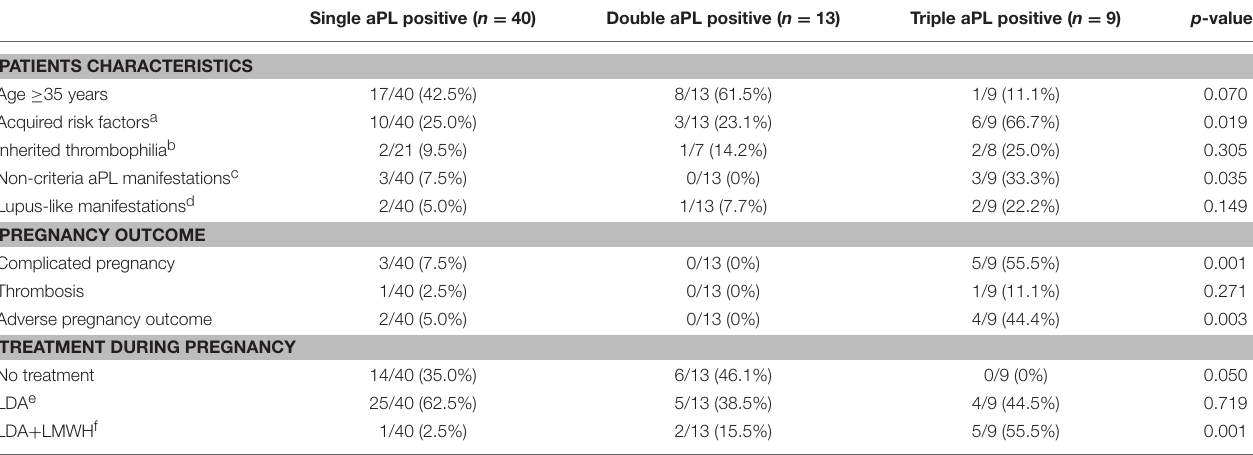
TABLE 2 | Analysis according to the type of aPL profile: comparison between triple aPL positive patients and the pool of single and double aPL positive